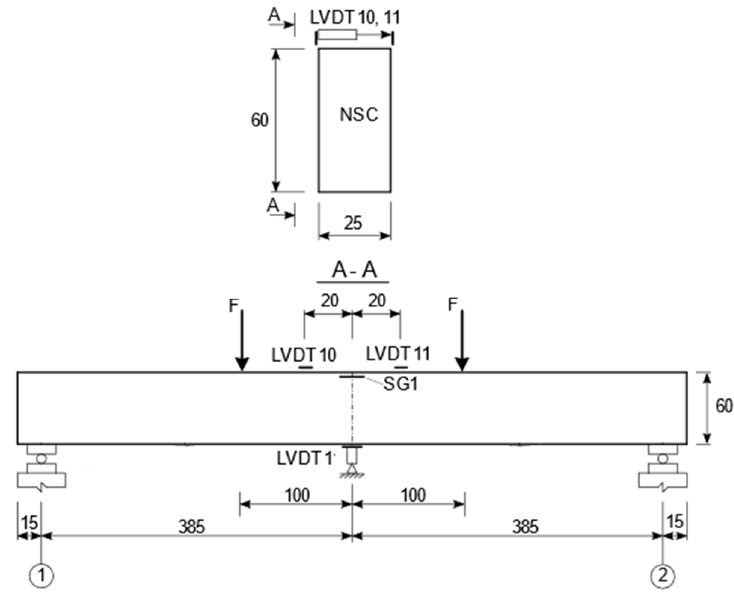
Figure 3. Location of measurement equipment on the tested specimens.